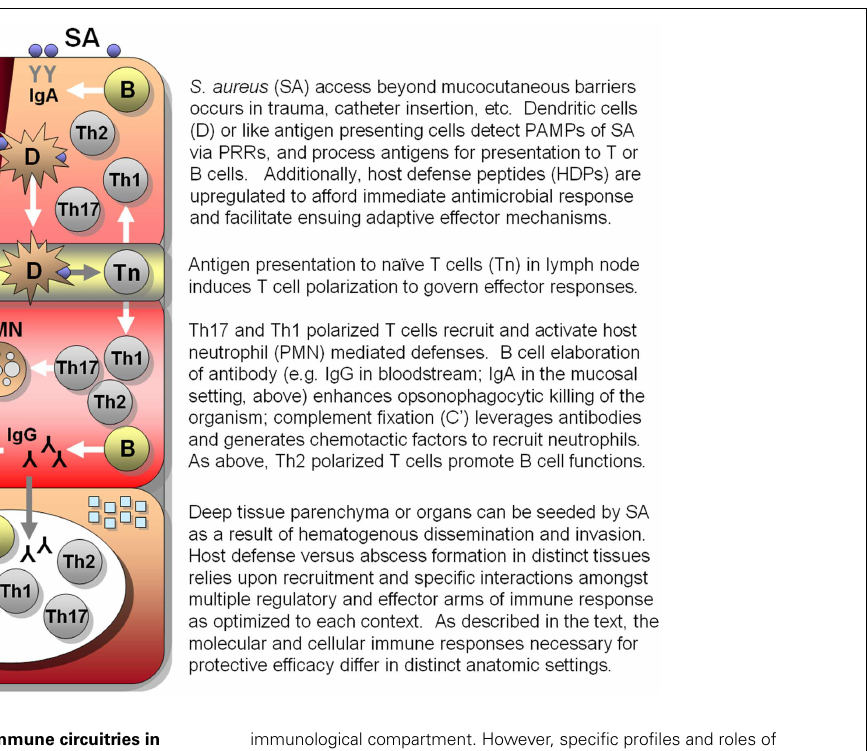
FIGURE 1 | Hypothesized integrated human immune circuitries in host defense against S. aureus infection. In this illustration, three distinct immunological compartments are shown. Note that lymphocytes, phagocytes, antibody, and molecular effectors (e.g., host-defense peptides, complement, antibody) may be present in each